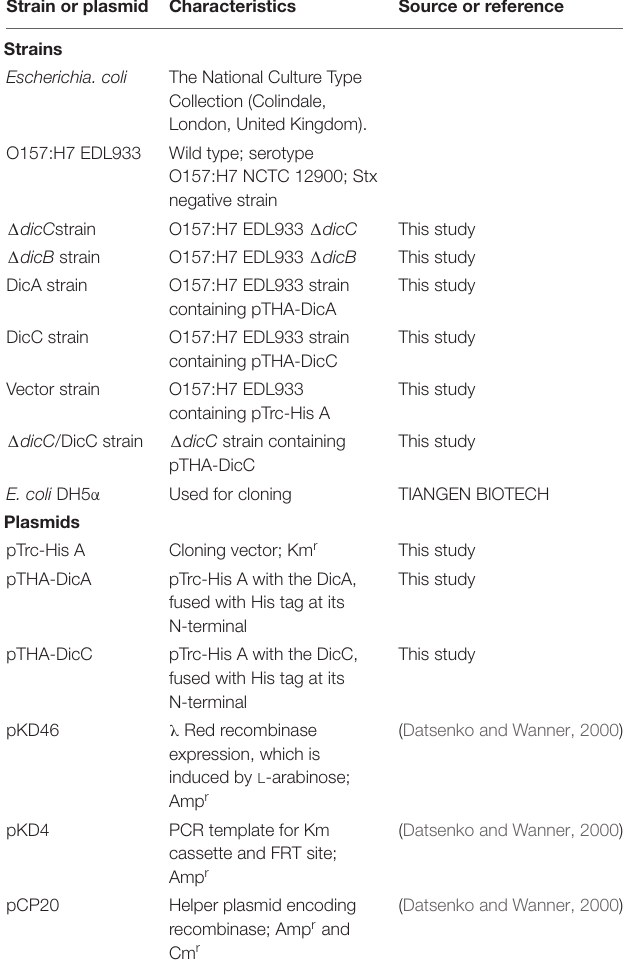
TABLE 1 | Bacterial strains and plasmids used in this